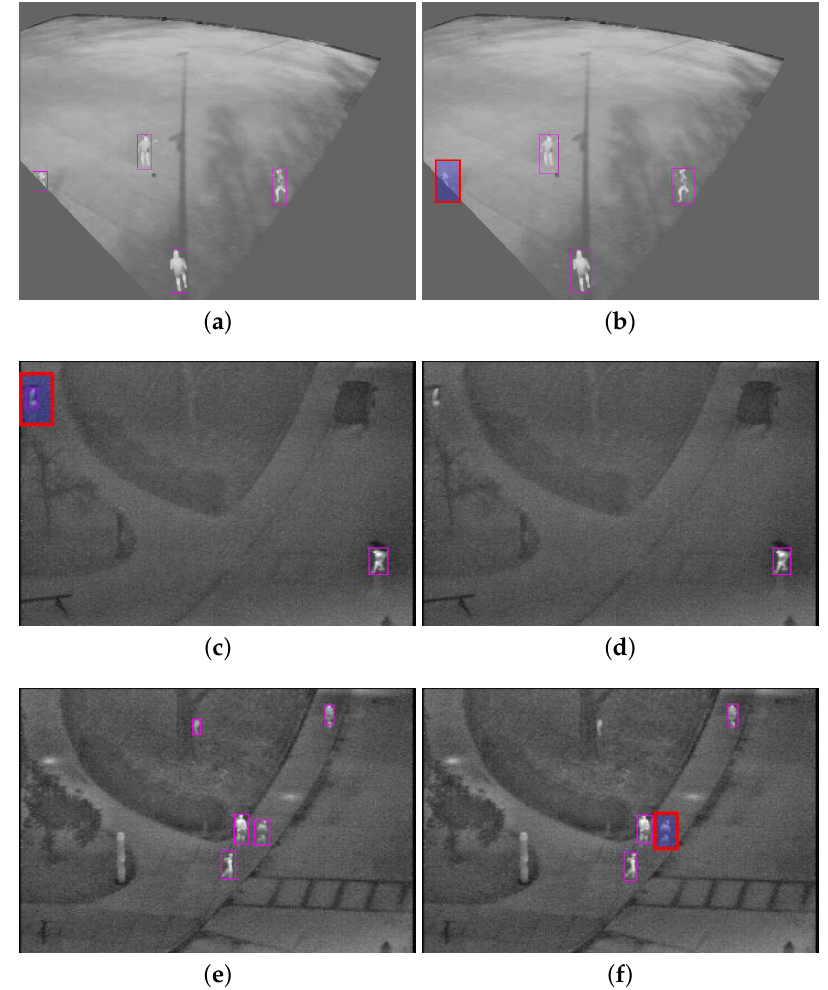
Figure 4. Example images for qualitative assessment. ( a , c , e ) are the results for Combination 16, while ( b , d , f ) are the results for the same images from Combination 12. The images ( a , b ) are from our test data, and the images ( c – f ) are from OSU-T [18]. In these images, highlighted red boxes are incorrect